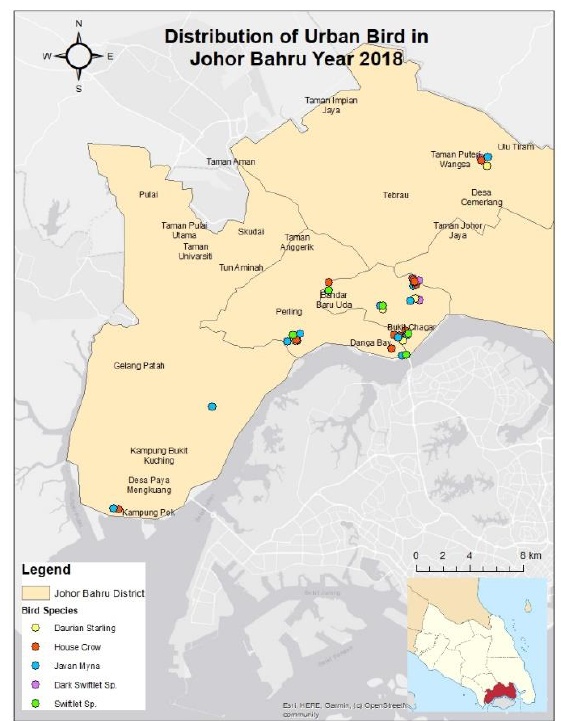
Figure 3 Distribution of urban bird by species in year 2018